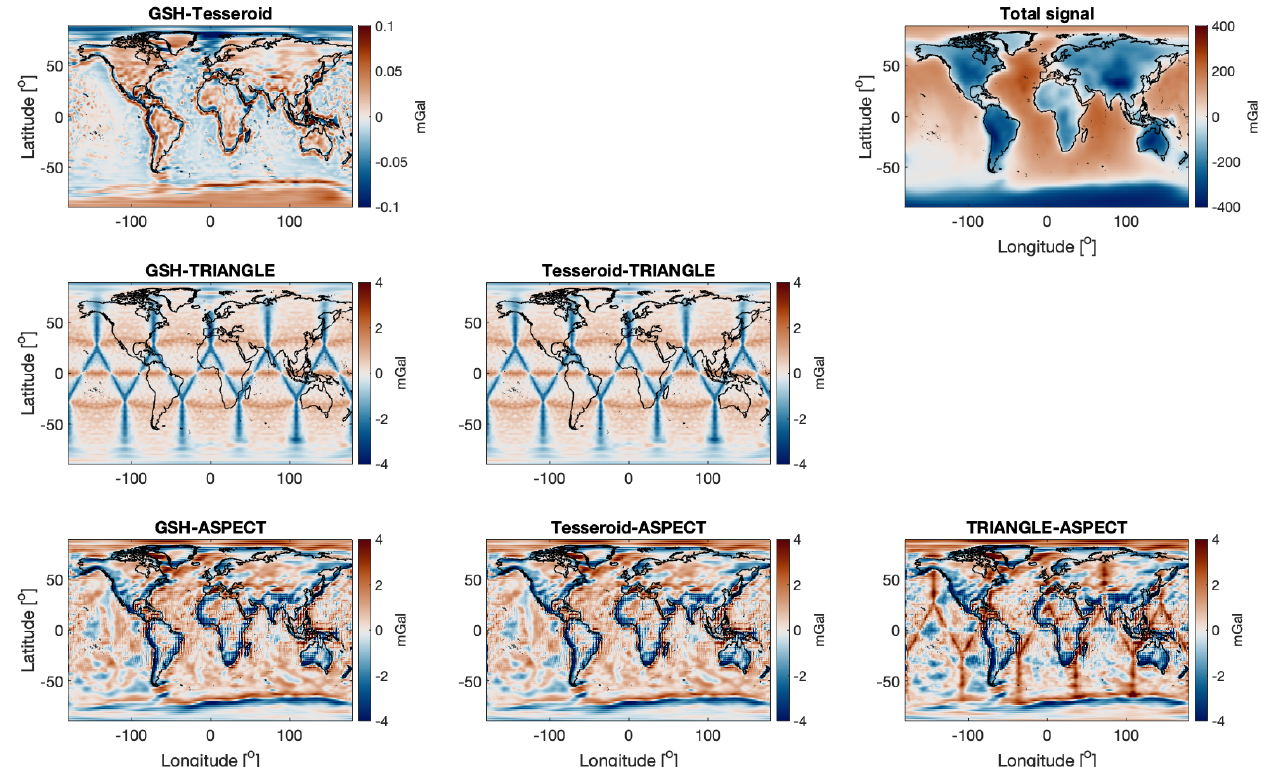
Figure 7. Radial gravity component comparisons at 250km height for shell test 3, wherein a density shell of equal thickness is modelled with a density contrast at the CRUST1.0 Moho boundary.